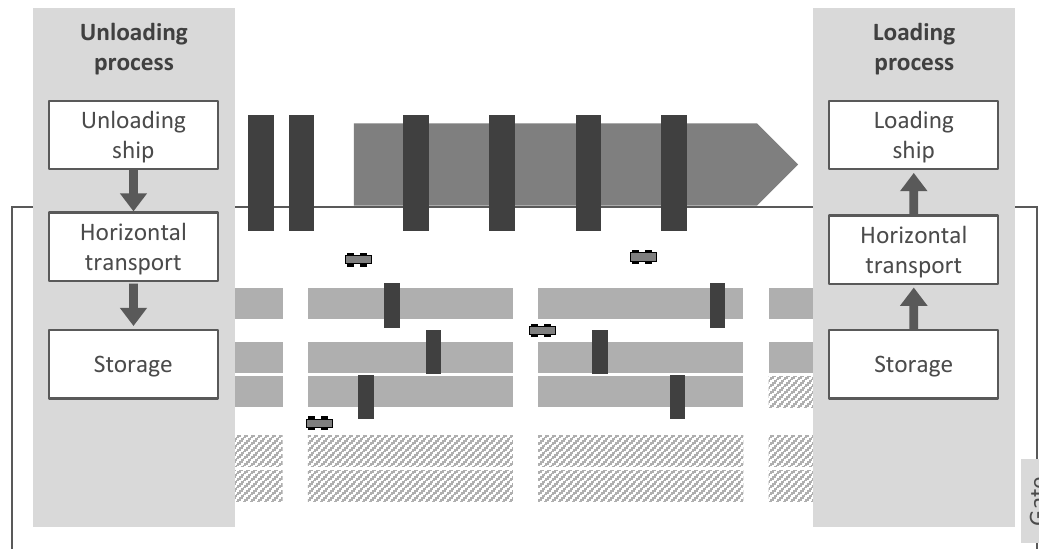
Figure 2. Layout and process illustration of the simulation